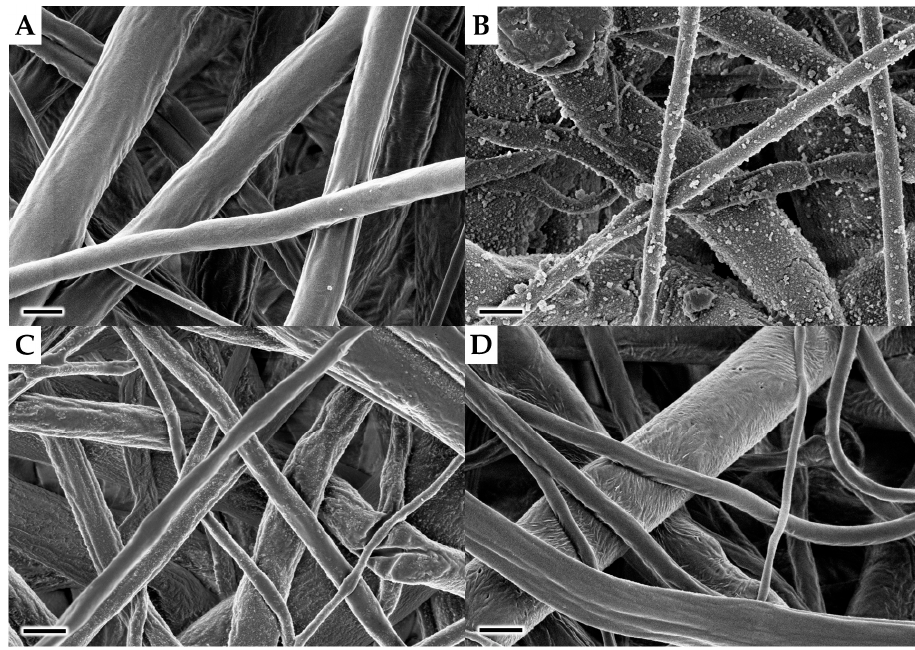
Figure 2. Scanning electron microscope (SEM) images of ( a ) PCL; and polycaprolactone-poly [6-(pyrrol-3-yl)hexanoic acid] (PCL-PPyHA) scaffolds prepared using ( b ) 60% methanol in water ( v / v ); ( c ) 95% methanol in water ( v / v ); and ( d ) 100% methanol. Scale bar 1 μ m.